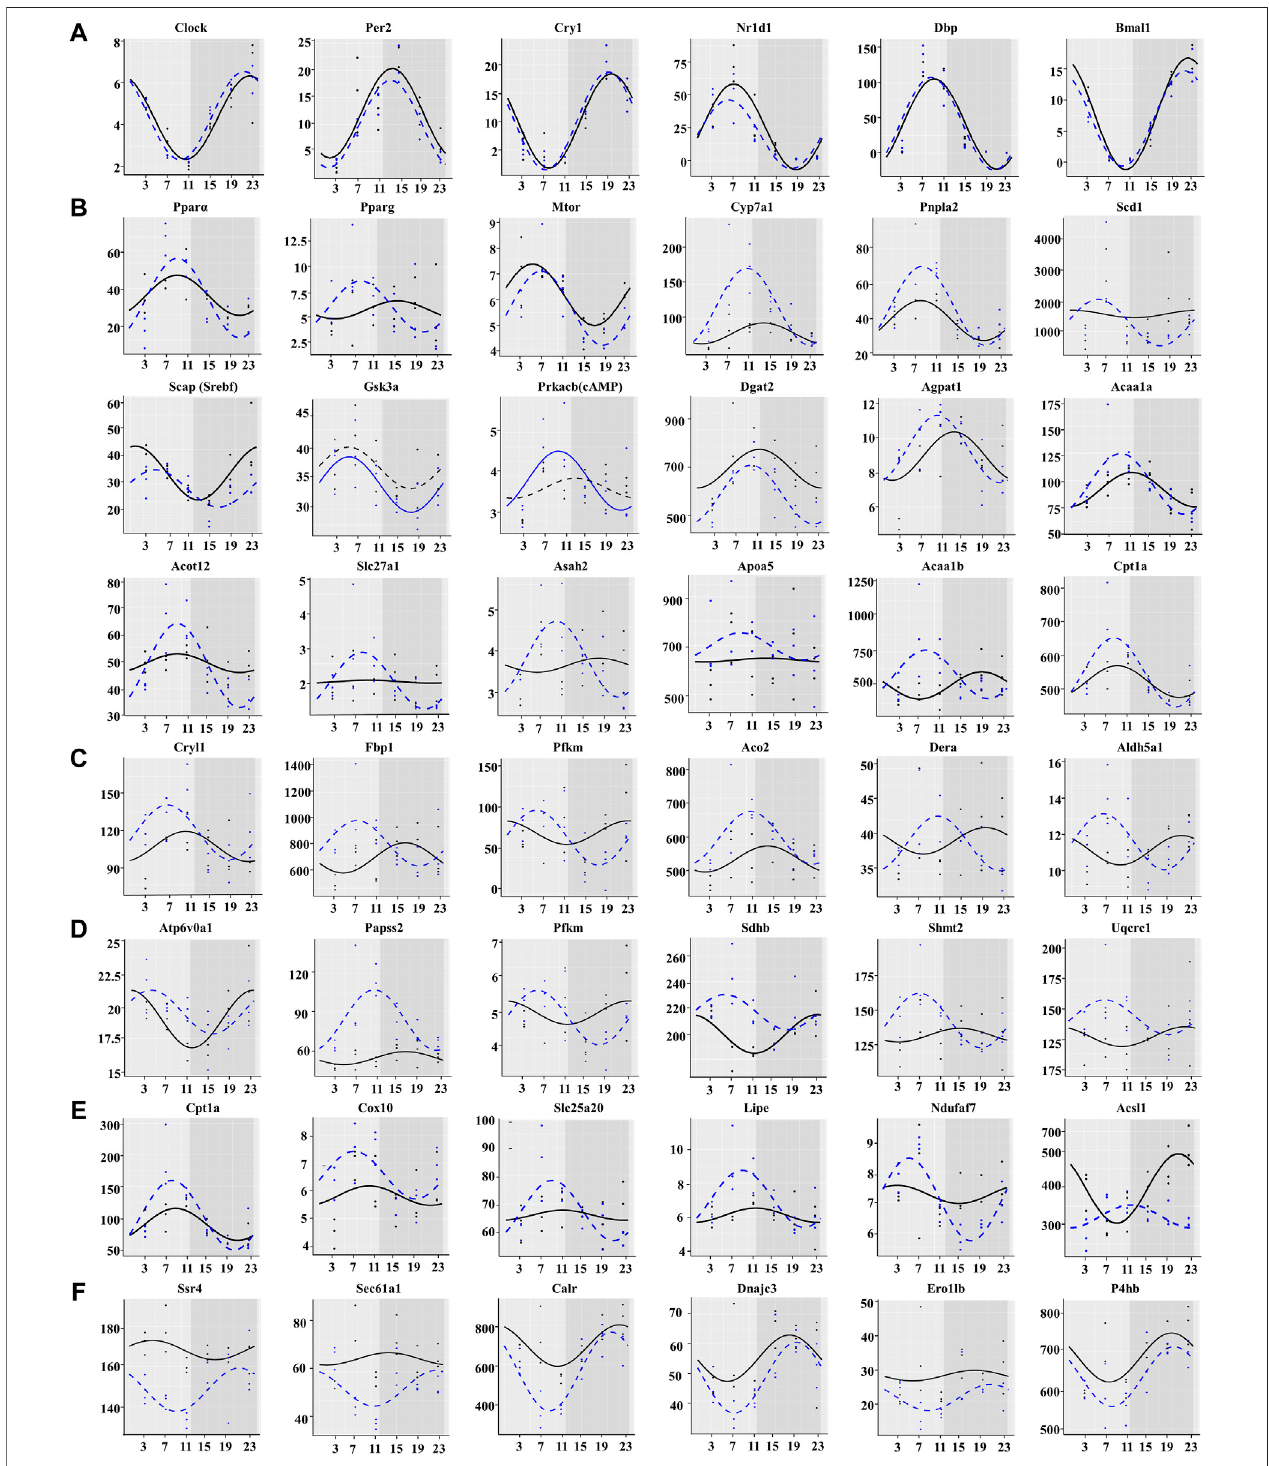
FIGURE 6 | Chronic cold exposure synchronizes the expression of a large number of metabolic genes. (A) Expression of core clock genes, (B) lipid metabolism genes, (C) carbohydrate metabolism genes, (D) energy metabolism genes, (E) thermogenesis genes, and (F) protein processing in endoplasmic reticulum genes. The black line indicates the control group, and the blue dotted line indicates the chronic cold (CC) group. Points are individual data points, and lines represent cosinor regression fi t.